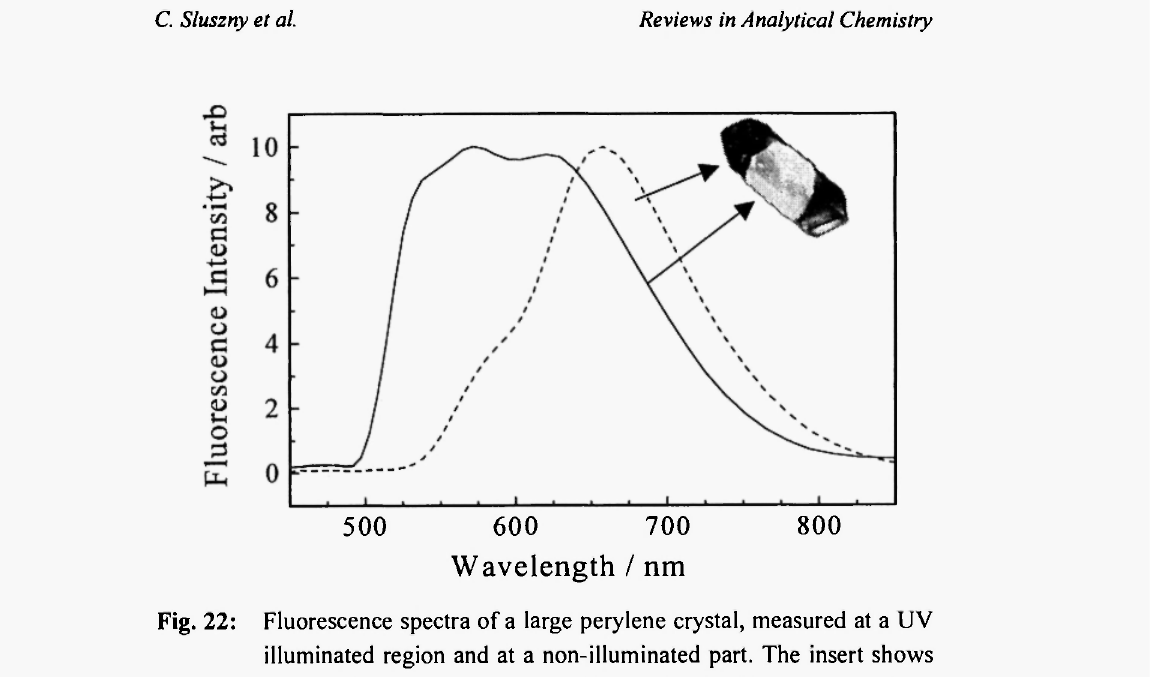
Fig. 22: Fluorescence spectra of a large perylene crystal, measured at a UV illuminated region and at a non-illuminated part. The insert shows the actual fluorescence pattern, illustrating the illuminated and the non-illuminated crystal